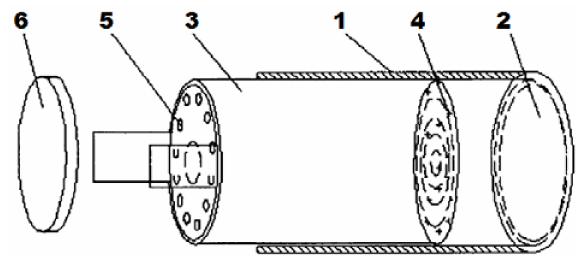
Figure 16. Schematic diagram of a wide temperature range cell with 1: can, 2: Ni-foam mat, 3: electrode assembly, 4: Cu-web with spikes, 5: positive current collector, and 6: vent cap FB